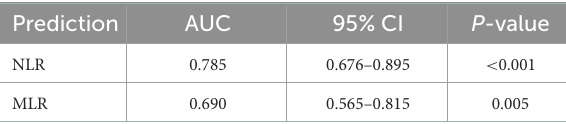
TABLE 4 Receiver operating characteristic curve-related statistical